Question: Identify the chart type used in this figure.
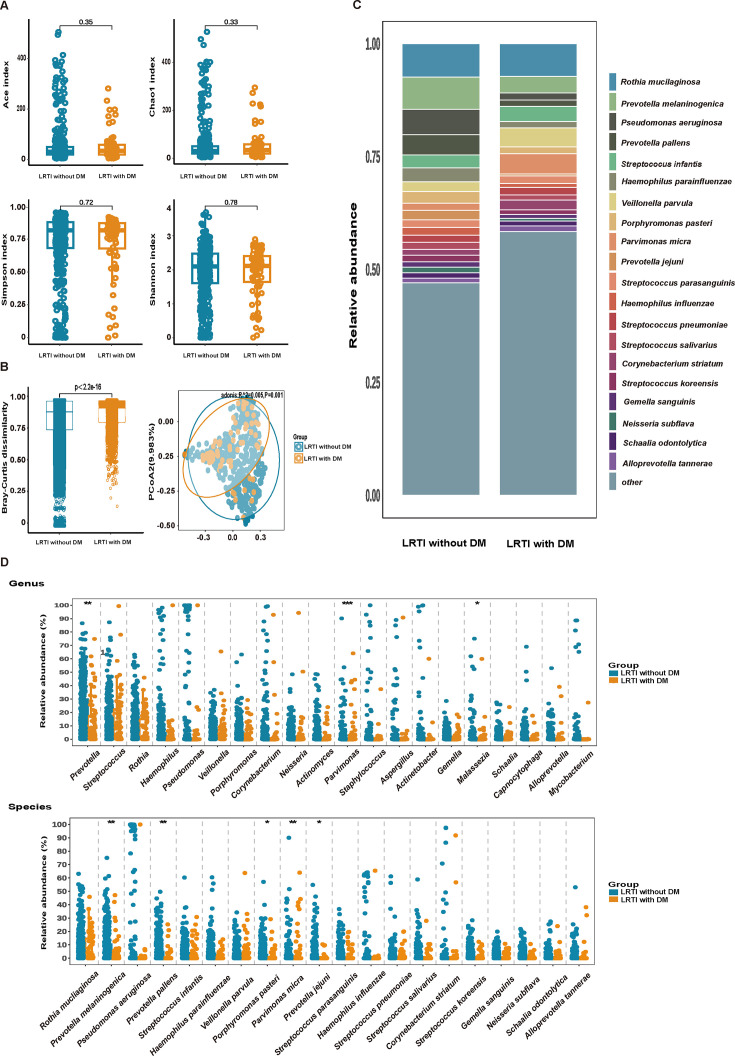
Answer: bar